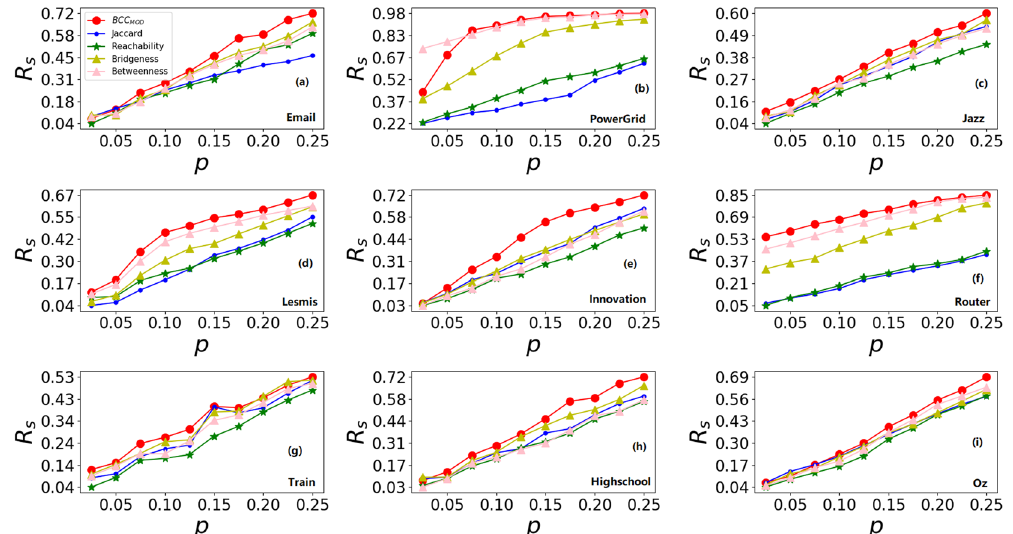
Figure 4. The relative differences of real infected scale R s over each node as seed under different ratio of edges removing p. All results are averaged over 100 independent implementations under μ / μ c =